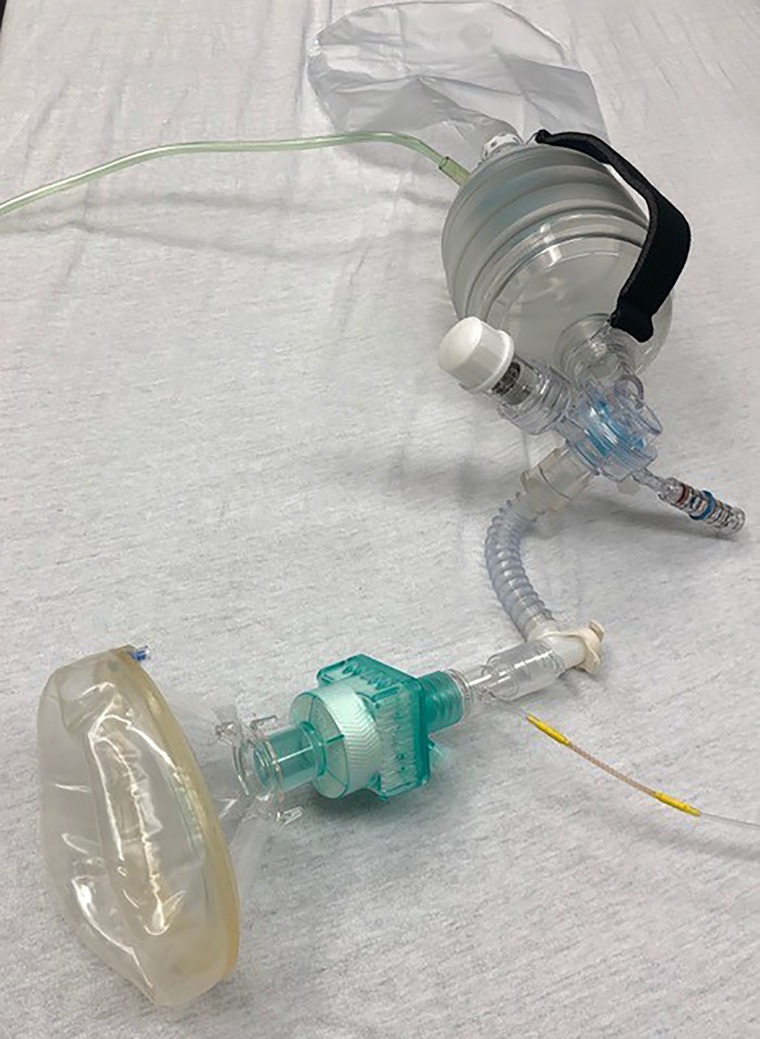
Modified BVM with Viral Filter, ETCO2, flexible mount (allows for more range of motion of device and less of a fulcrum at face) attached to BVM with PEEP valve and pressure monometer.